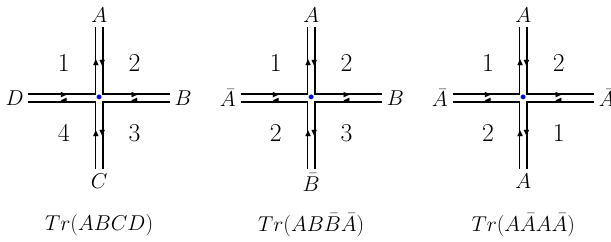
Figure 17 . The three types of squares that enter a quadrangulation. The original vertices 1 ; 2 ; 3 ; 4 are now faces tha lie between the new